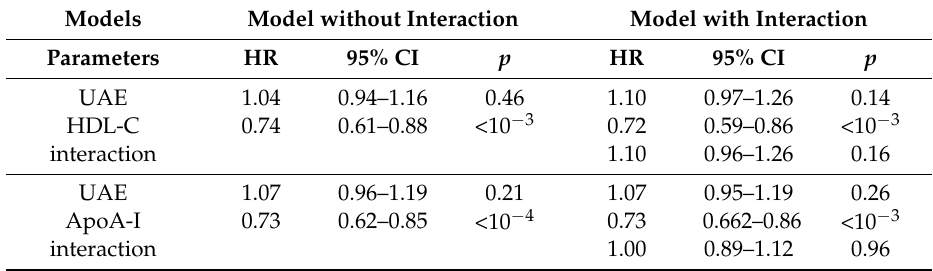
Table 3. Interaction of UAE with HDL-related parameters for baseline evaluation data as assessed by Cox proportional hazards models of cardiovascular event occurrence concurrently adjusted for gender, age, apoB concentration, diabetes, past CVD history, C-reactive protein (CRP) concentration, and